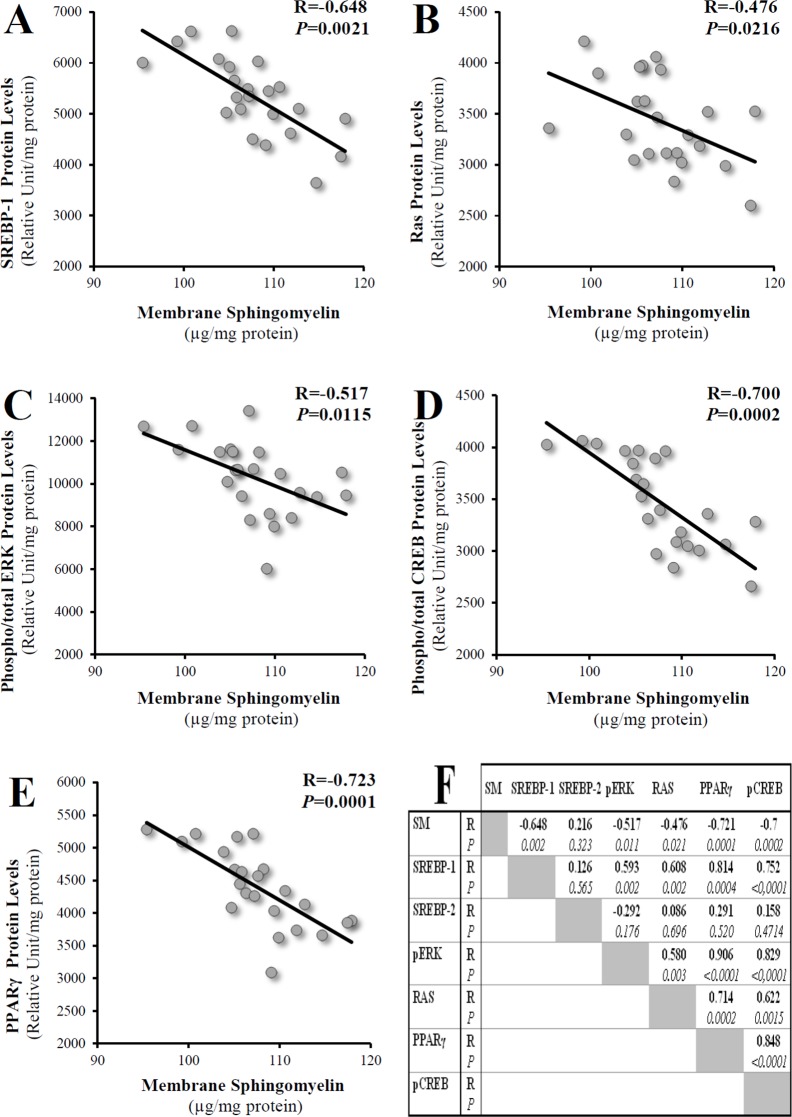
Relations between SM accumulation and SREBP-1, Ras, ERK, CREB and PPARγ proteins in human subcutaneous adipose tissue.R, coefficient of correlation; statistical significance was set at P<0.05. Membrane SM levels refer to total membrane levels.